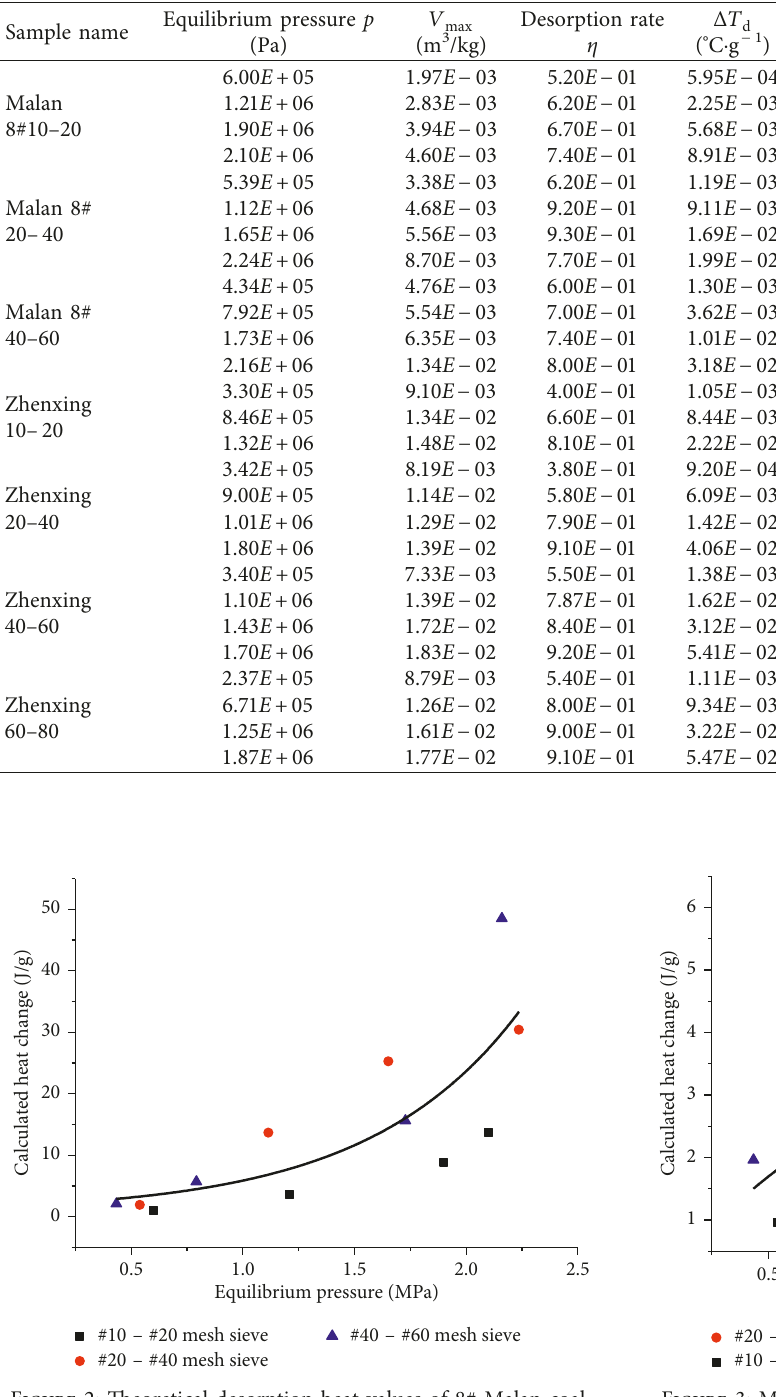
Table 1: Theoretical and measured values of the two types of coal samples.